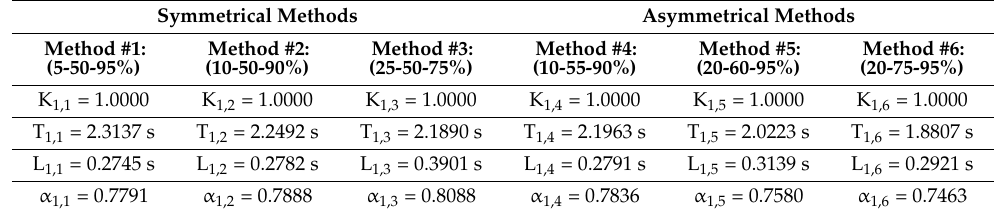
Table 11. Fractional-order model settings for the symmetrical and asymmetrical sets of points (5-50- 95%), (10-50-90%), (25-50-75%), (10-55-90%), (20-60-95%), and (20-75-95%), respectively, applied to Example 1. Symmetrical Methods